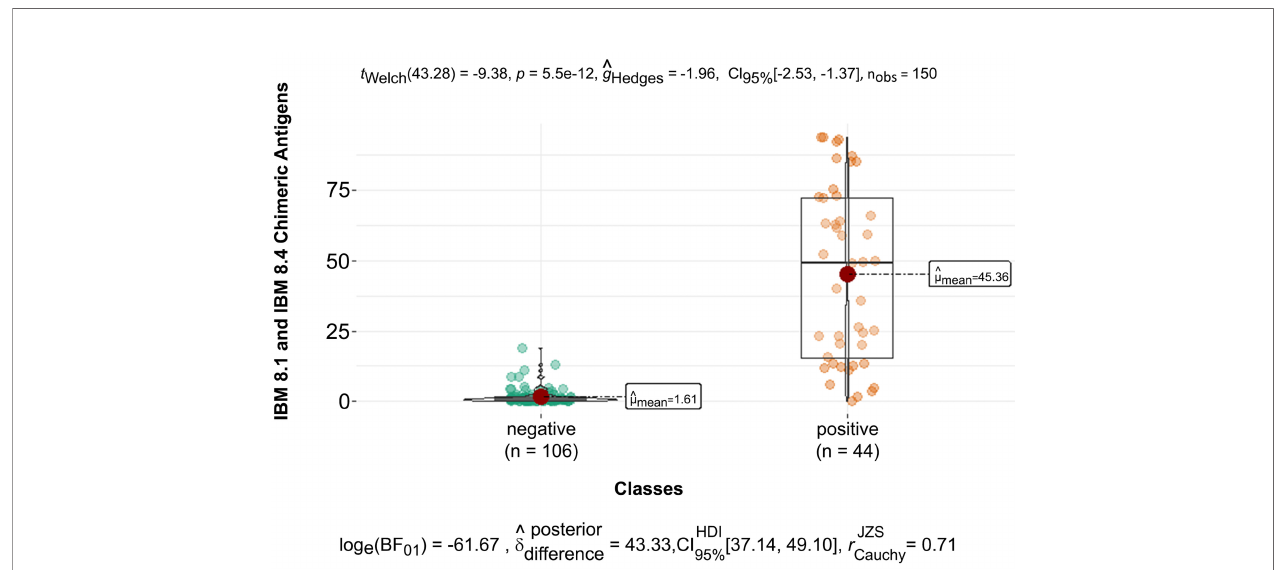
FIGURE 3 | BoxPlot with the distribution of mean values of optical densities and mean values of negative and positive samples from dogs infected by Trypanosoma cruzi against the chimeric antigens IBMP-8.1 and IBMP-8.4.